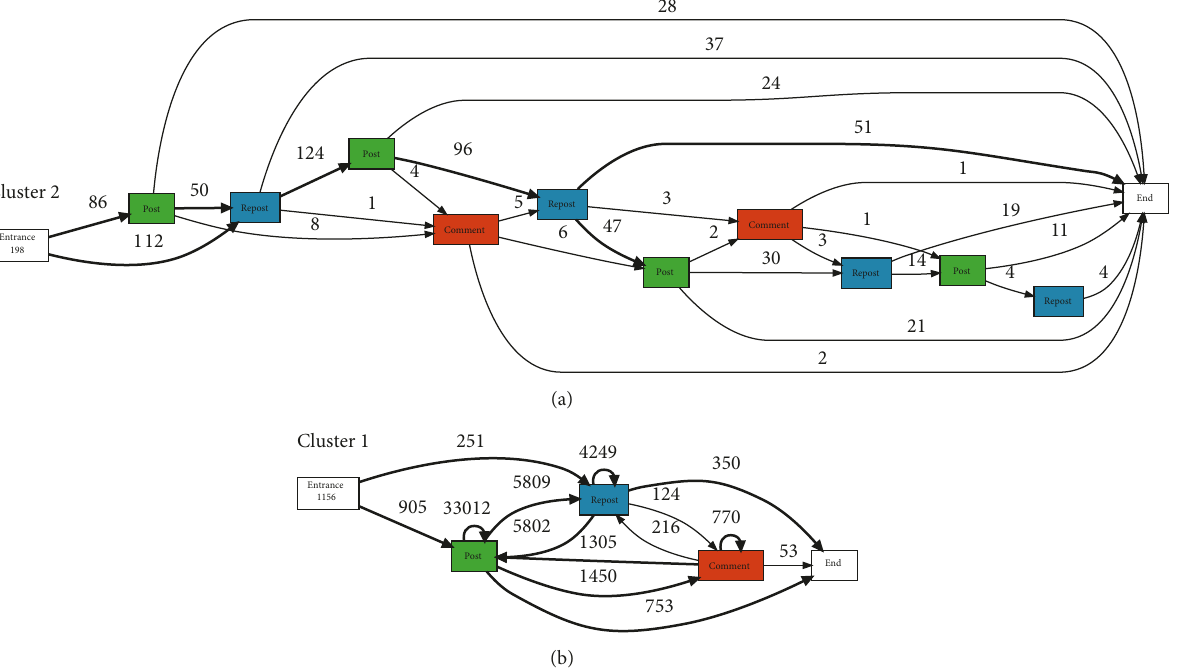
Figure 12: Example of process model (a) with expanded cycles and (b) with collapsed